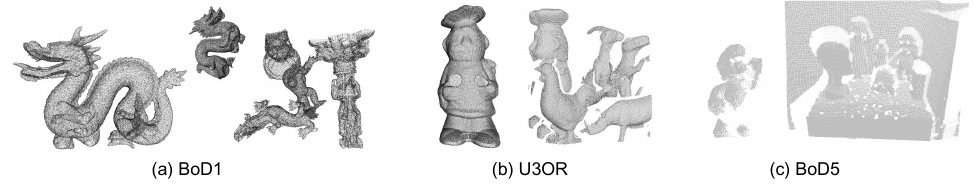
Figure 4. Visualization of three sample point cloud pairs from the experimental